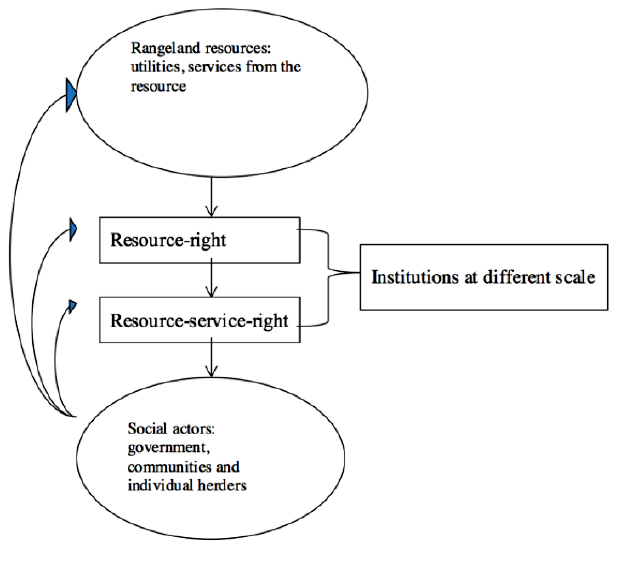
Fig. 1 . An analytical framework. The difference between a resource-right and a resource-service-right is that the former focuses on rangeland as an independent resource, whereas the latter focuses on rangeland as an integrated part of a coevolved, pastoral social-ecological system. The mapping processes of resource-rights and resource-service-rights are mediated by various types of institutions operating at different